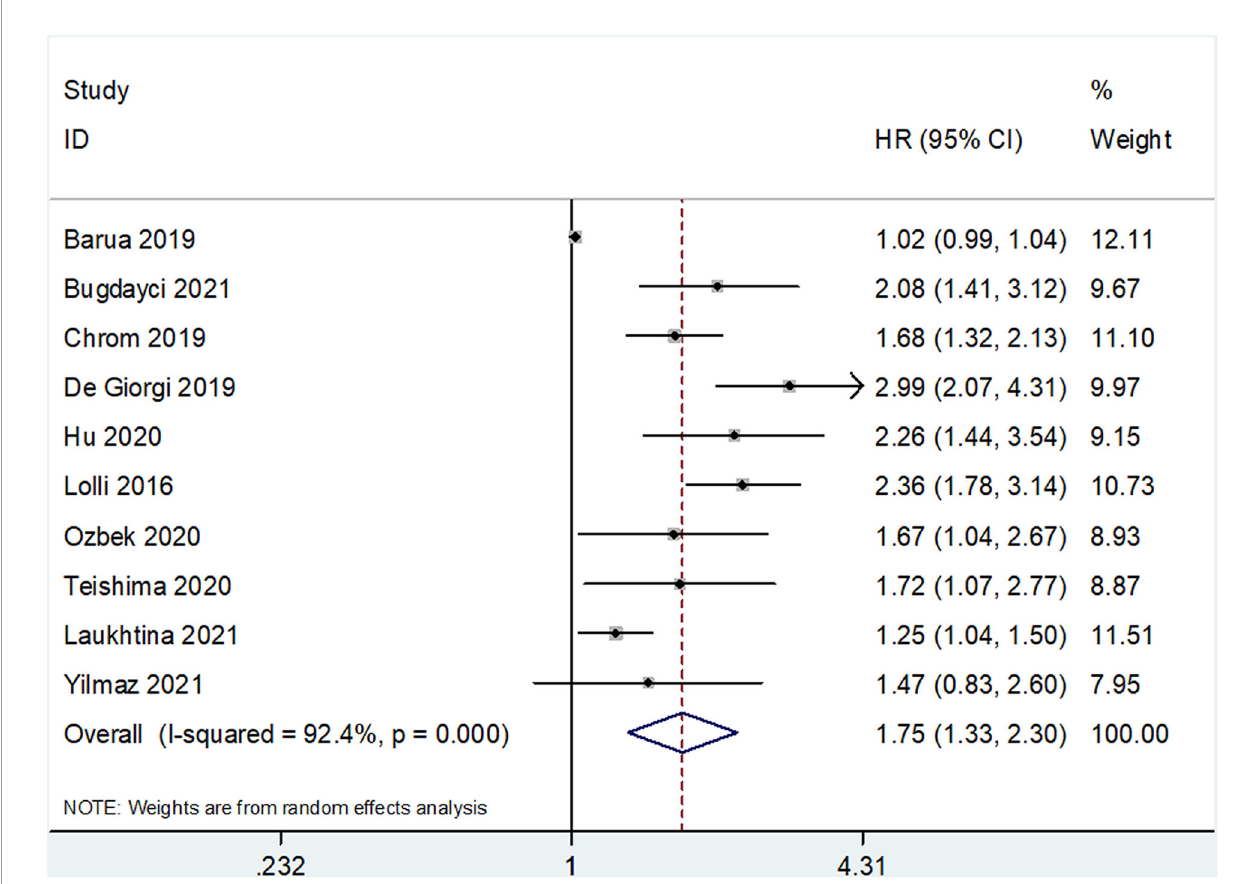
FIGURE 2 | Forest plots showing the association between SII and overall survival (OS) in renal cell carcinoma